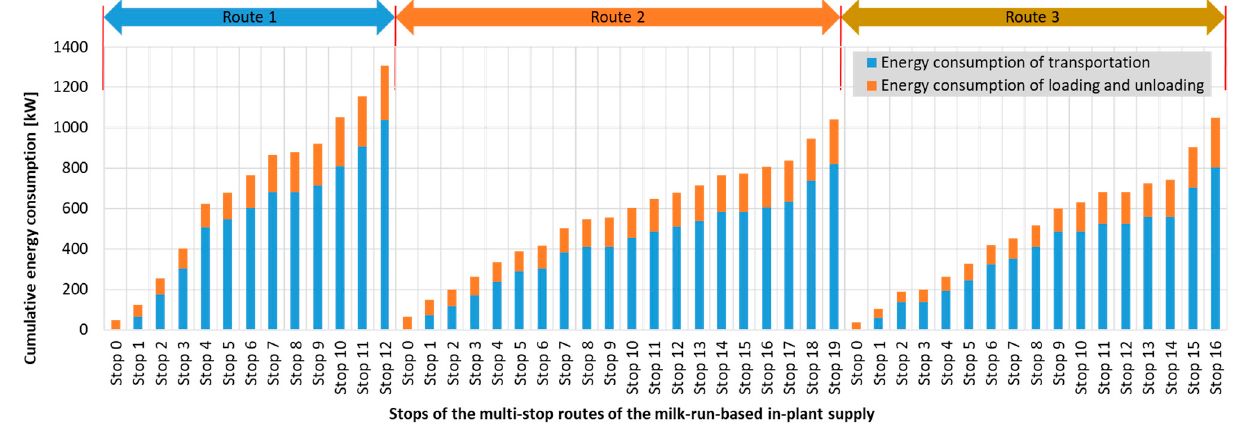
Figure 7. Cumulative energy consumption of the three milk-run routes in the case of conventional real-time routing and scheduling.